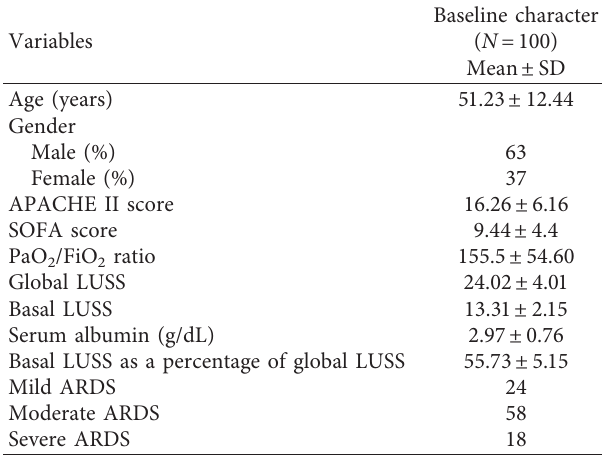
Table 2: Depiction of demographic and variables of the study.